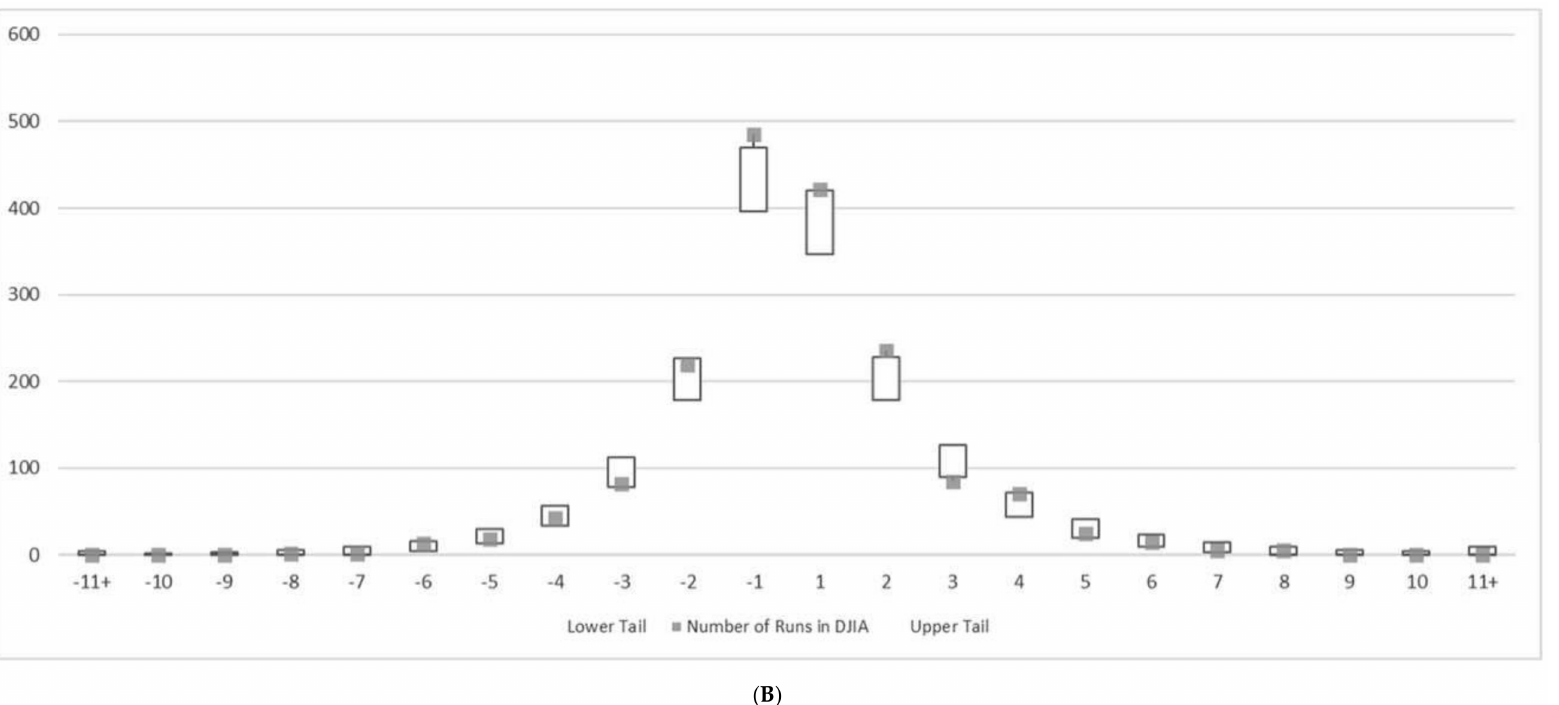
Figure 2. ( A ) DSEX Number of n Day Runs and 95% Confidence Intervals; ( B ) DJIA Number of n Day Runs and 95% Confidence